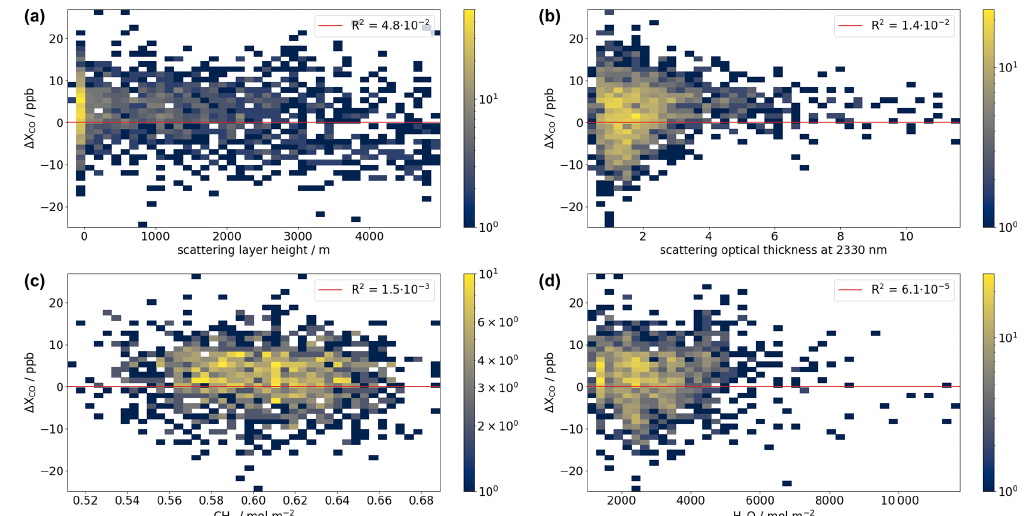
Figure 7. Absolute differences between TROPOMI XCO observations and our EM27/SUN measurements plotted as a function of the SICOR/TROPOMI retrieval parameters scattering layer height (a) , scattering optical thickness (b) , interfering CH 4 ( c , from weak two-band total column), and interfering H 2 O (d) . The color code indicates (logarithmic) occurrence, and the red line is a linear fit with its coefficient of determination R 2 given in the upper right of each